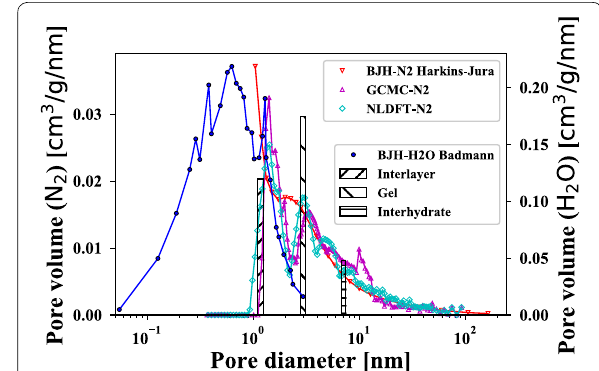
Fig. 9 Influence of pretreatment on nitrogen sorption isotherm, experimental data from Sugimoto et al. (2017).